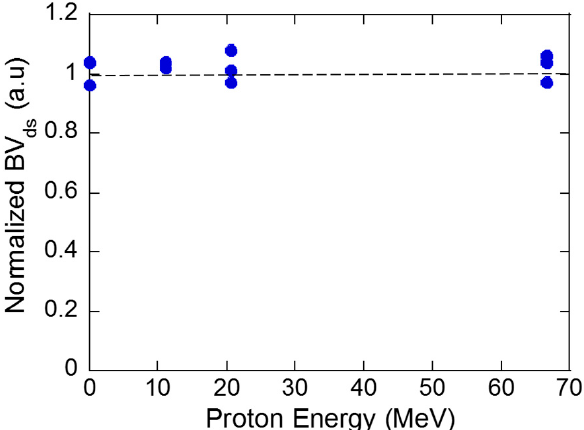
Figure 11. Normalized off-state ( V gs = − 5.0 V) drain breakdown voltage ( BV ds ) of HEMT under 11.1– 66.8 MeV proton irradiation.